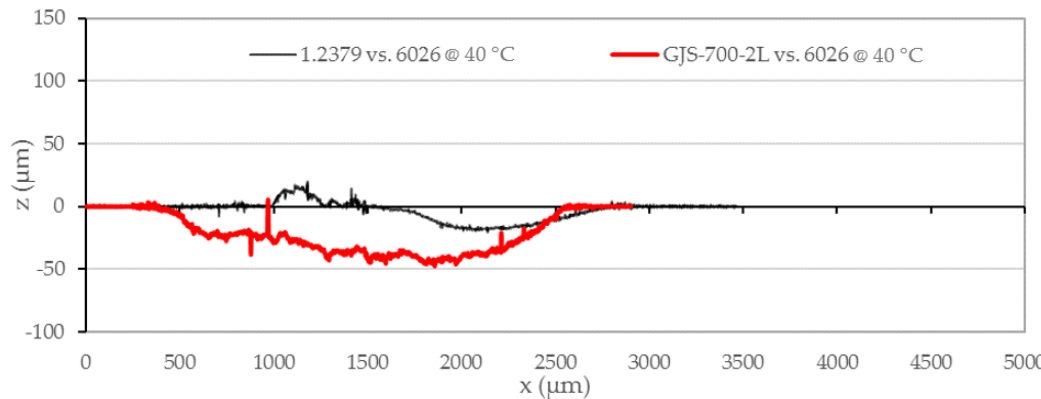
Figure 7. Depth profile of the track. Tool steel vs. cast iron wear profile comparison at 40 °C.